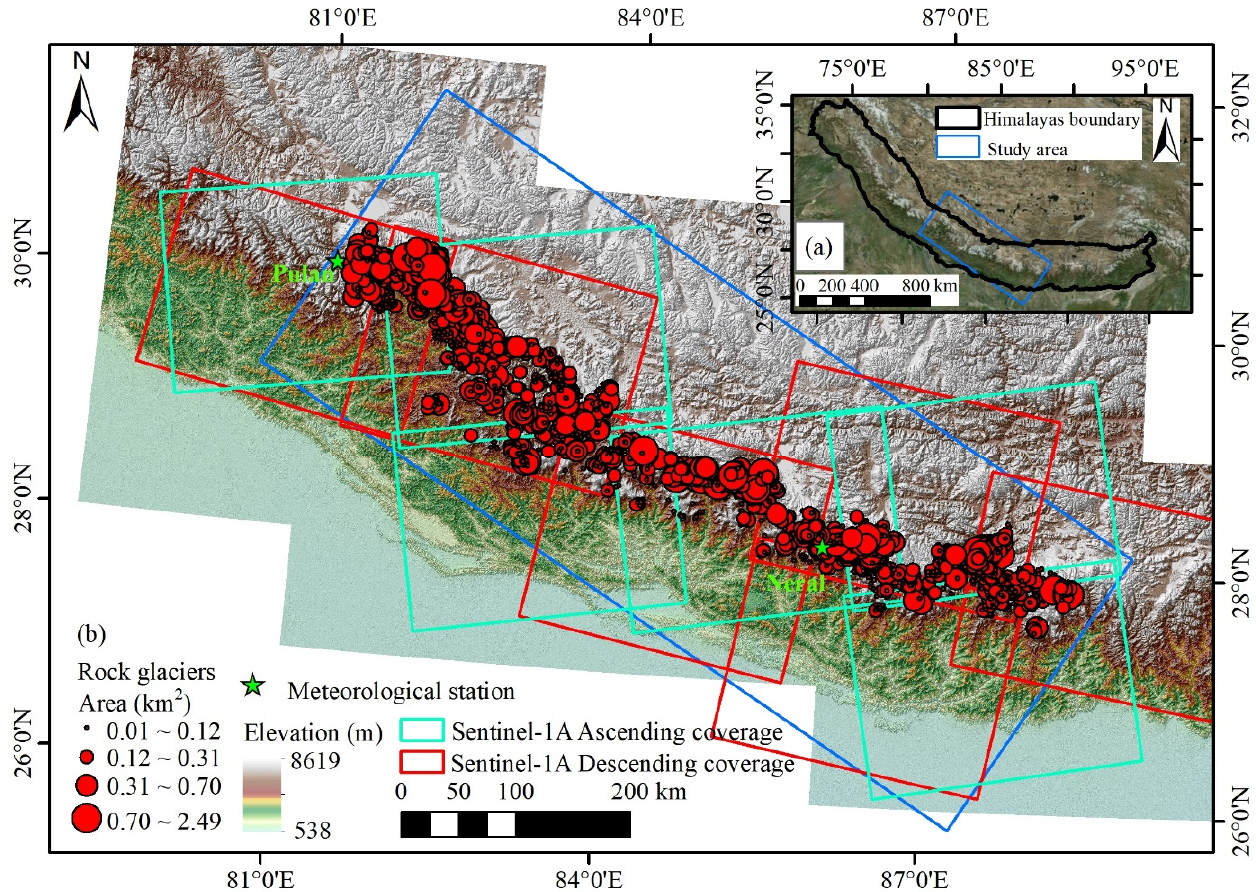
Figure 1. ( a ) Overview of the study area. ( b ) Footprints of Sentinel-1 ascending and descending images and distribution of rock glaciers. In the background is the elevation of the study area.